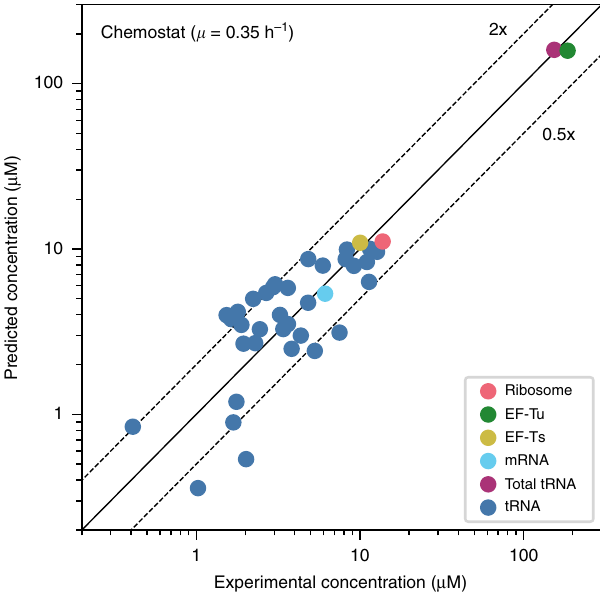
Fig. 3 Growth rate dependence of predicted (red lines) and observed concentrations. a EF-Tu, R 2 = 0.79, GMFE = 1.27. b EF-Ts, R 2 = 0.79, GMFE = 1.25. c Total ribosome concentration (arithmetic means across ribosomal proteins). d Actively elongating ribosomes, estimated from data in c according to ref. 32 (see Methods). Circles indicate normal conditions, triangles indicate stress conditions. Source data are provided as a Source Data fi le.